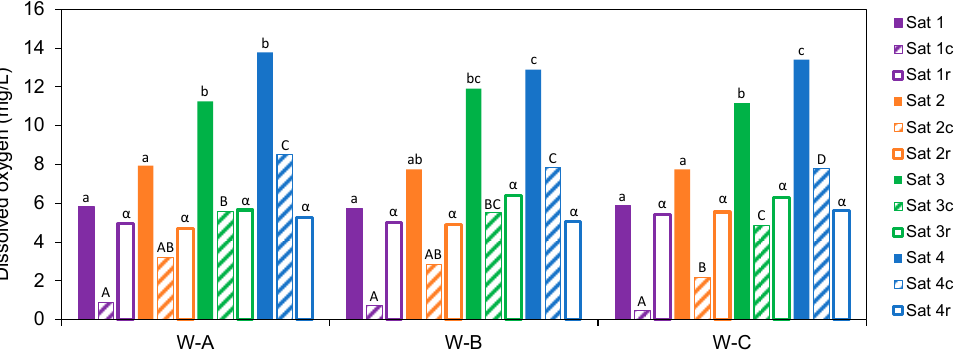
Figure 2. Dissolved oxygen level (mg/L) consumed (c) and remaining (r) ( : dosed oxygen; oxygen consumed; : remaining oxygen) (Sat-1: purple, Sat-2: orange, Sat-3: green, and Sat-4:blue). For each wine, different letters indicate significant differences among different saturation levels ( α < 0.05), lower case letters for the oxygen dose, capital letters for oxygen consumed and Greek letters for oxygen remaining level.